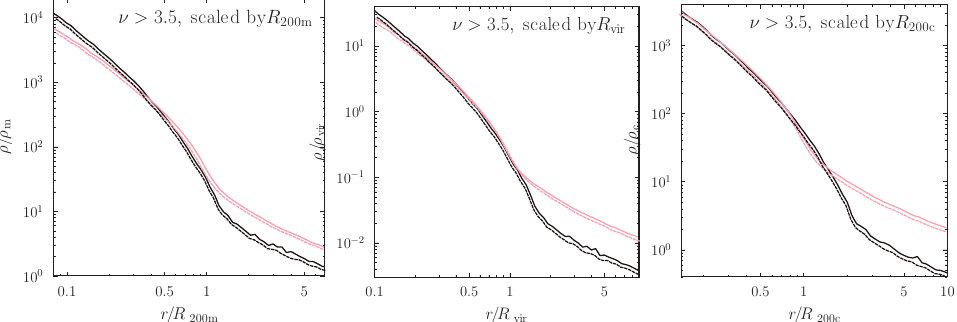
Figure 2. Self-similarity of the redshift evolution of the profiles. In all panels, solid lines represent the results from [19] while dotted lines show results obtained with our model. Left panel: redshift evolution of the median density profiles for a peak with ν > 3.5 as a function of the radius rescaled by R 200 m and with density rescaled by ρ m . Central panel: the same density profiles rescaled by R vir and ρ vir , respectively. Right panel: the same density profiles rescaled by R c , and ρ c , respectively. The black lines correspond to z = 0 and the red lines to z =